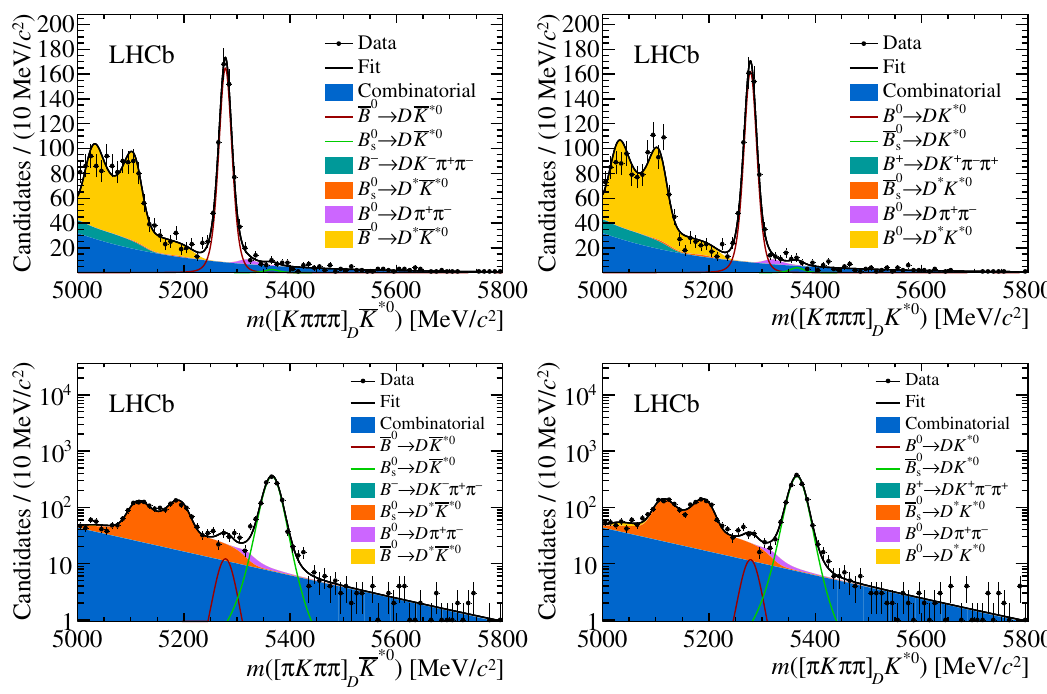
Figure 5 . Invariant-mass distributions (data points with error bars) and results of the (cid:12)t (lines and coloured areas) for the four-body ADS modes (top left) B 0 ! D ( K (cid:0) (cid:25) + (cid:25) (cid:0) (cid:25) + ) K (cid:3) 0 , (top right) B 0 ! D ( K + (cid:25) (cid:0) (cid:25) + (cid:25) (cid:0) ) K (cid:3) 0 , (bottom left) B 0 ! D ( (cid:25) (cid:0) K + (cid:25) + (cid:25) (cid:0) ) K (cid:3) 0 and (bottom right) B 0 ! D ( (cid:25) + K (cid:0) (cid:25) (cid:0) (cid:25) + ) K (cid:3) 0 . The bottom distributions are shown on a logarithmic